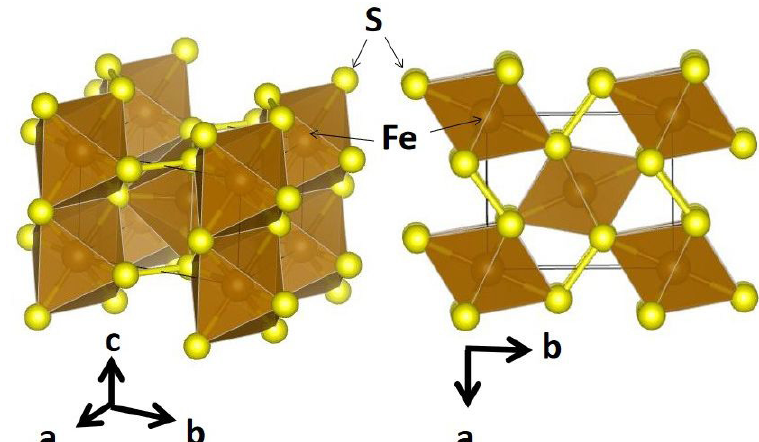
), polyhedral representation (Fe: brown spheres inside polyhedra, 2